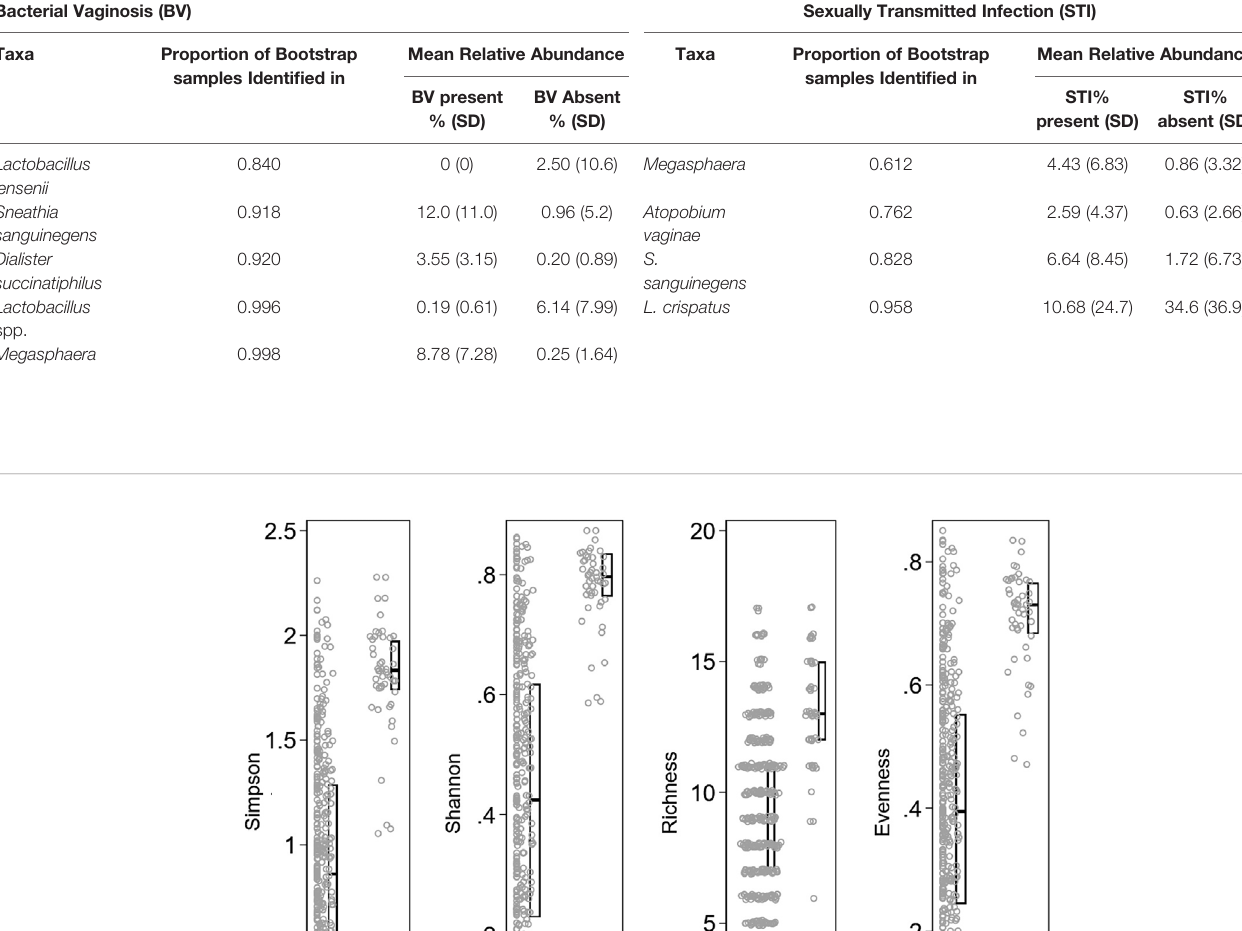
TABLE 3 | Results of stability selection with p=0.20 Error Bound.